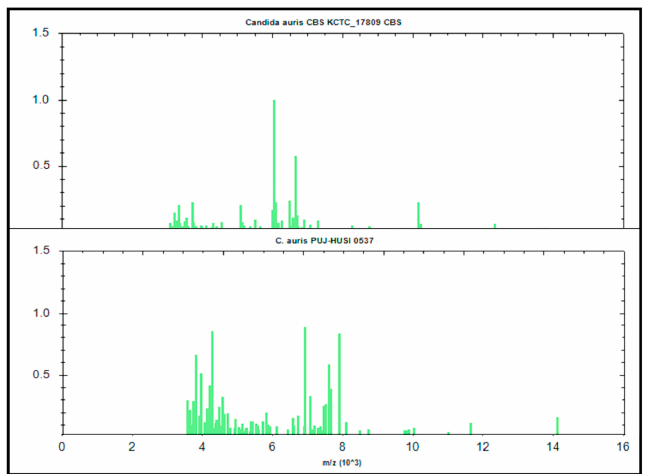
Figure 3. C. auris MSP from BDAL library (upper) and another one selected MSP from Colombian strains (lower).